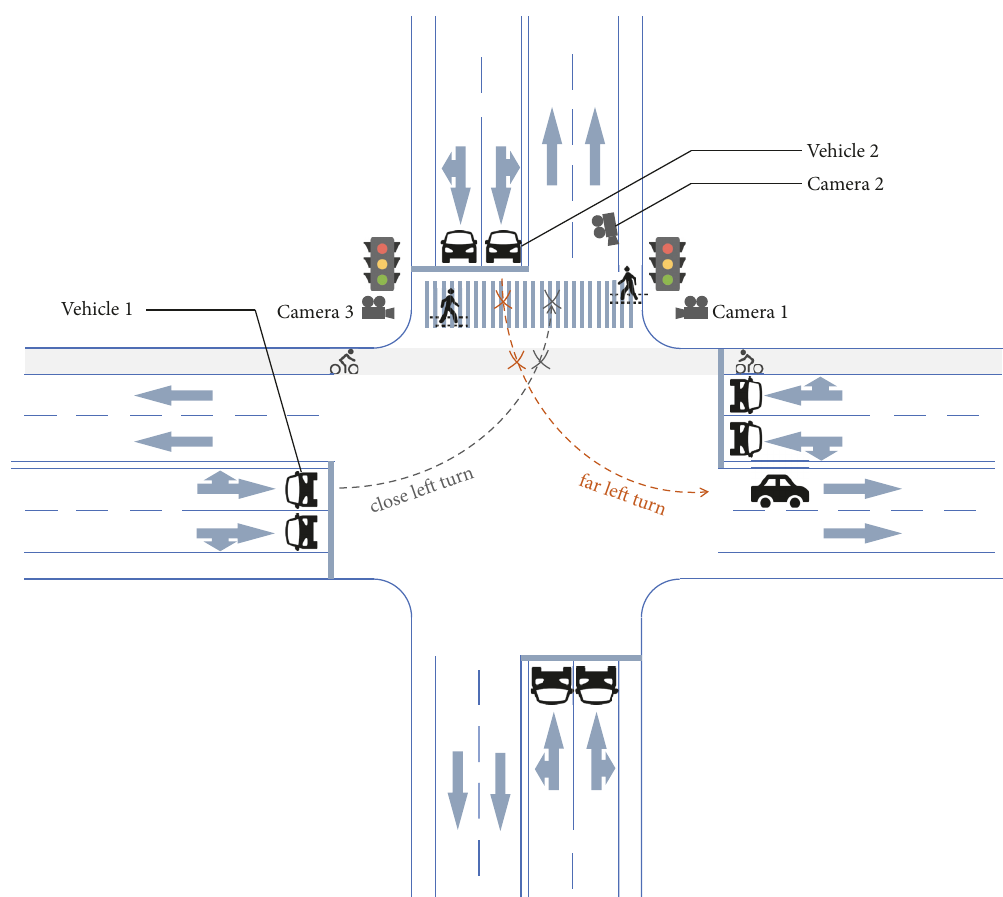
Figure 4: Illustration of the concepts of close left turn and far left